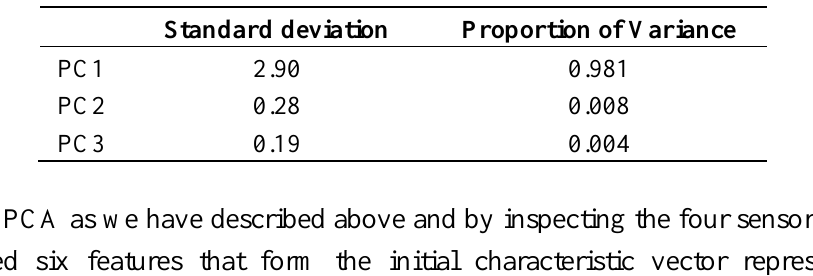
Table 1. Importance of the first three components.